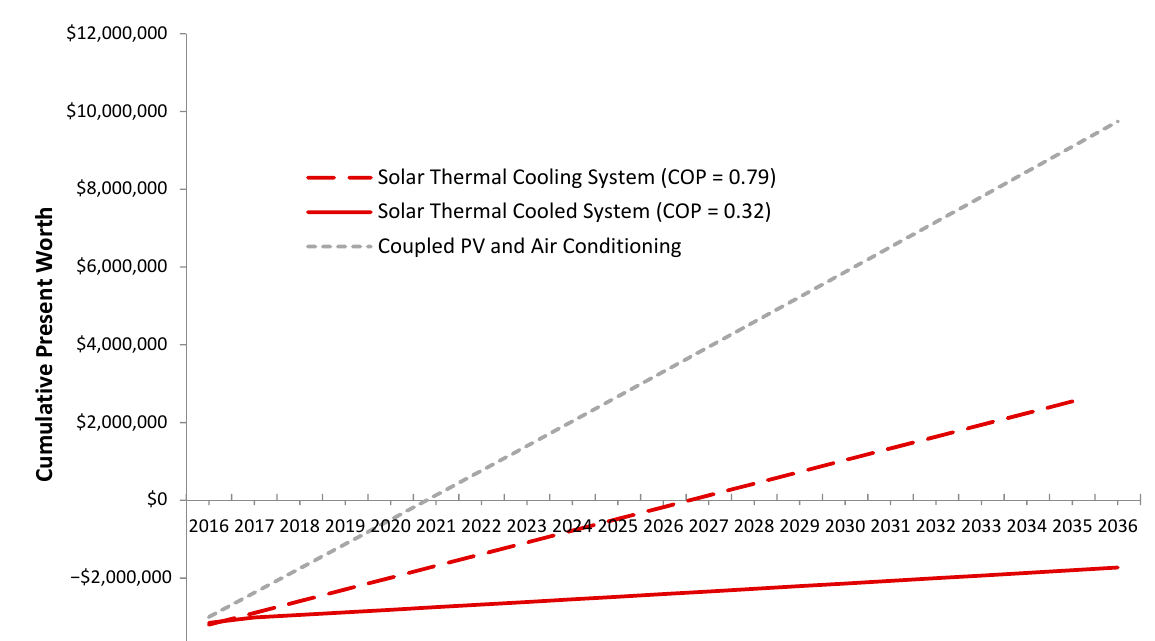
Figure 6. Payback period and the cumulative present worth across the lifespan for the two alternatives.